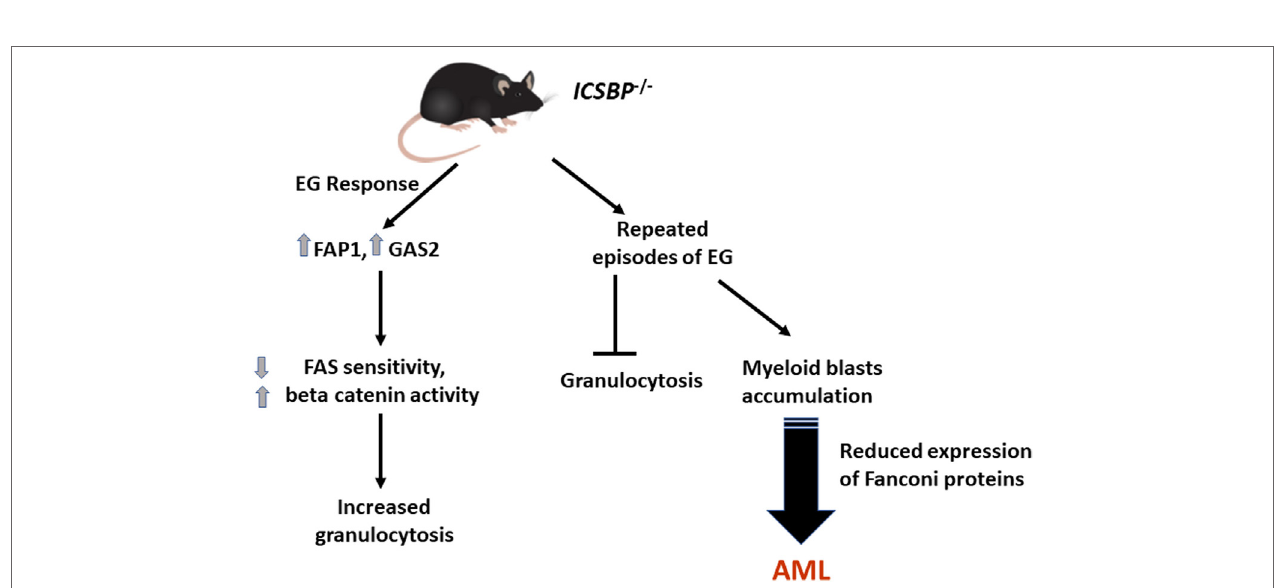
FiGURe 3 | Repeated episodes of emergency granulopoiesis (EG) lead to leukemia development in IRF8 − / − ( ICSBP − / − ) mice. A sustained expansion of neutrophils was observed in IRF8 − / − mice in response to EG through increased expression of FAP1 and GAS2 in bone marrow myeloid progenitors. However, repeated episodes of EG did not increase granulocytes in IRF8 − / − mice, but accumulation of myeloid blasts was found, leading to acute myeloid leukemia (AML) development. Reduced expression of FANCC and FANCF, which are IRF8 target proteins, contribute by increasing sensitivity to DNA damage in bone marrow myeloid